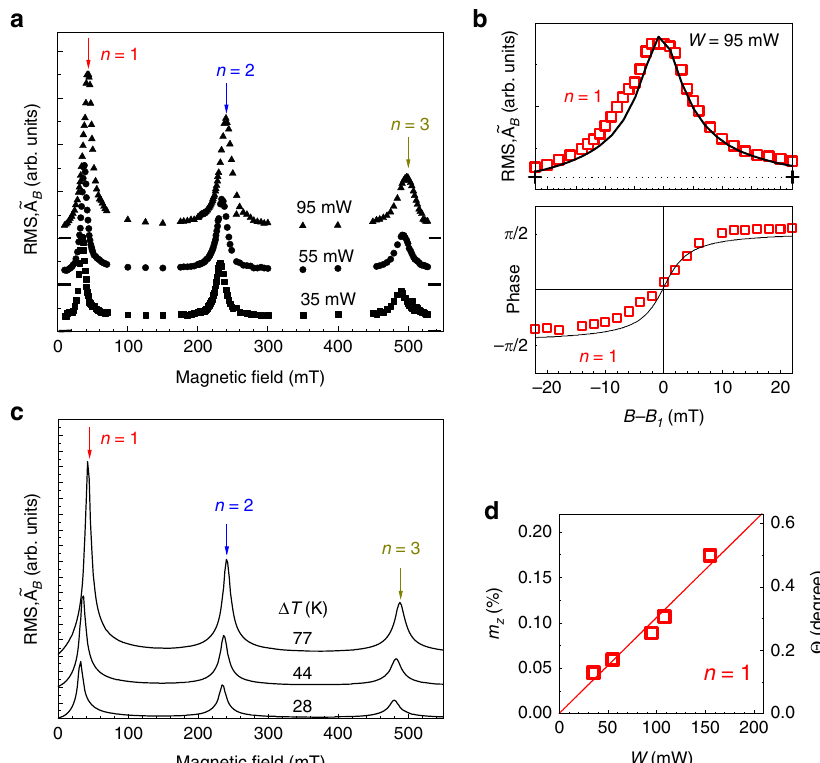
Fig. 3 Magnon spectra. a Measured magnetic fi eld dependences of the root-mean-square (RMS) amplitude of the Kerr rotation signal, ~ A B , for three values of pump excitation power, W . The vertical arrows indicate the magnetic fi elds B n at which the resonance condition f = f n is ful fi lled; the horizontal bars indicate zero signal levels. b Measured (symbols) and calculated (solid lines) zoomed fragments of the fi eld dependences of ~ A B (upper panel) and the phase (lower panel) in the vicinity of the fi rst resonance ( n = 1) for W = 95 mW; the dashed horizontal line shows ~ A B at the intermediate off-resonance fi eld. c Calculated fi eld dependences of the RMS precession amplitude for the background temperatures Δ T obtained from the experimental dependences in a . d Power dependence of the relative precession amplitude (left axis) and the corresponding precession angle (right axis) at the fi rst resonance ( n = 1) when f = f 0